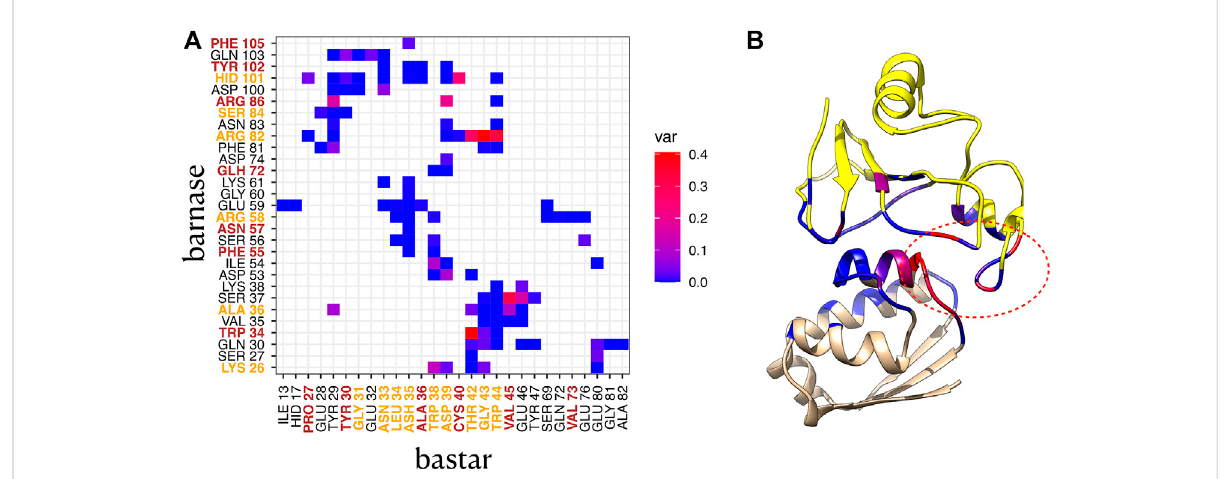
FIGURE 5 Contactvarianceincomplex1BRS. (A) varianceofeachcontactfrequencyacrossthetwointerfaceclusters.Residueslabeledinorangearecore residues,andresidueslabeledinbrownaresupportresiduesinthecrystallographicstructure.Protein1:barnase,protein2:barstar. (B) 3Dstructureof 1BRS,withbarnaseinyellow,andbarstarinbeige,andinterfaceresiduescoloredbycontactvariance(maximumvarianceperresidue).Theredellipse indicates the variable region of the